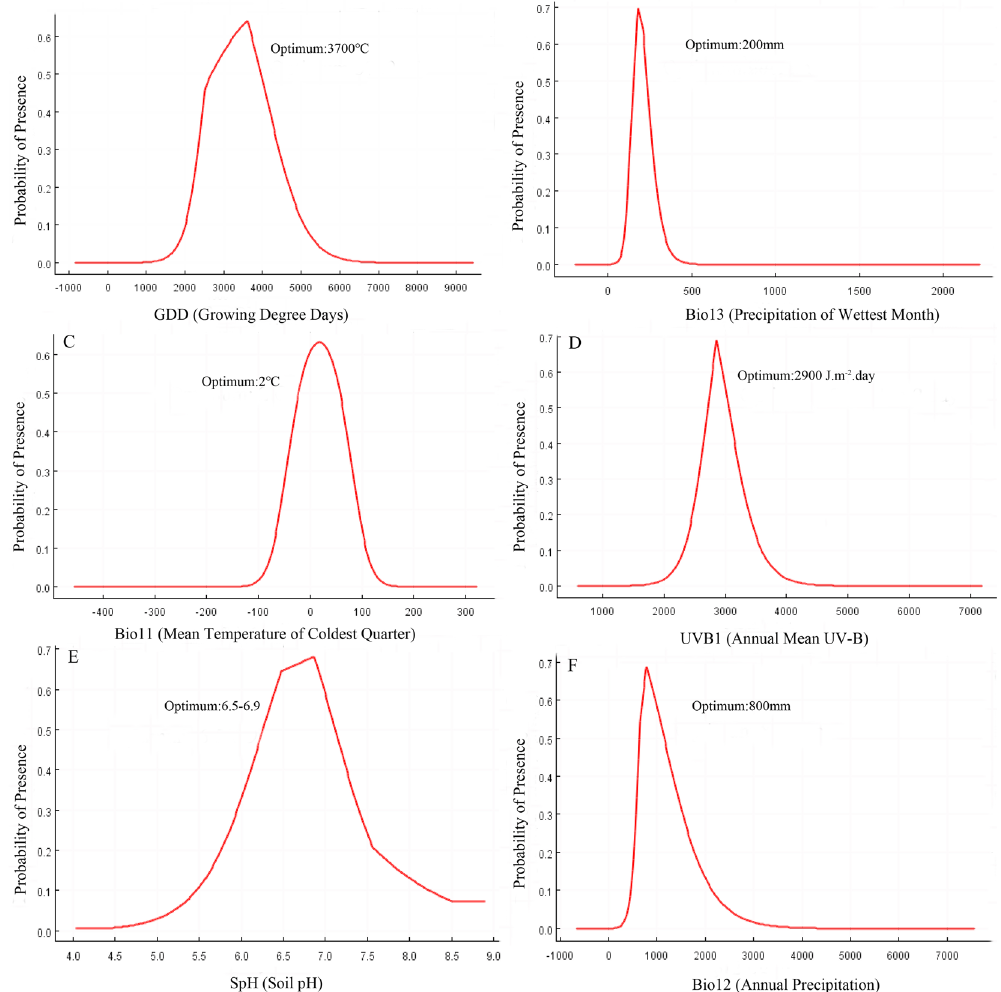
Figure 1. The distribution of occurrence records and the current spatial distribution map of P . ostii in China. Blue triangle indicates the occurrence records of P . ostii . Modelling of the current distribution of P . ostii was performed by MaxEnt v3.3.3 (http://www.cs.princeton.edu/~schapire/maxent/), and the whole map was generated using the tool of ArcMap 10.0 (ESRI, Redlands, CA, USA,